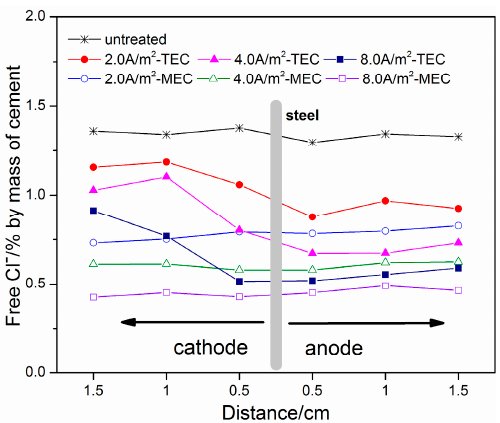
Figure 5. Free chloride concentrations versus locations from the steel to the anolyte or the catholyte (untreated, after the TEC treatment and the MEC treatment).